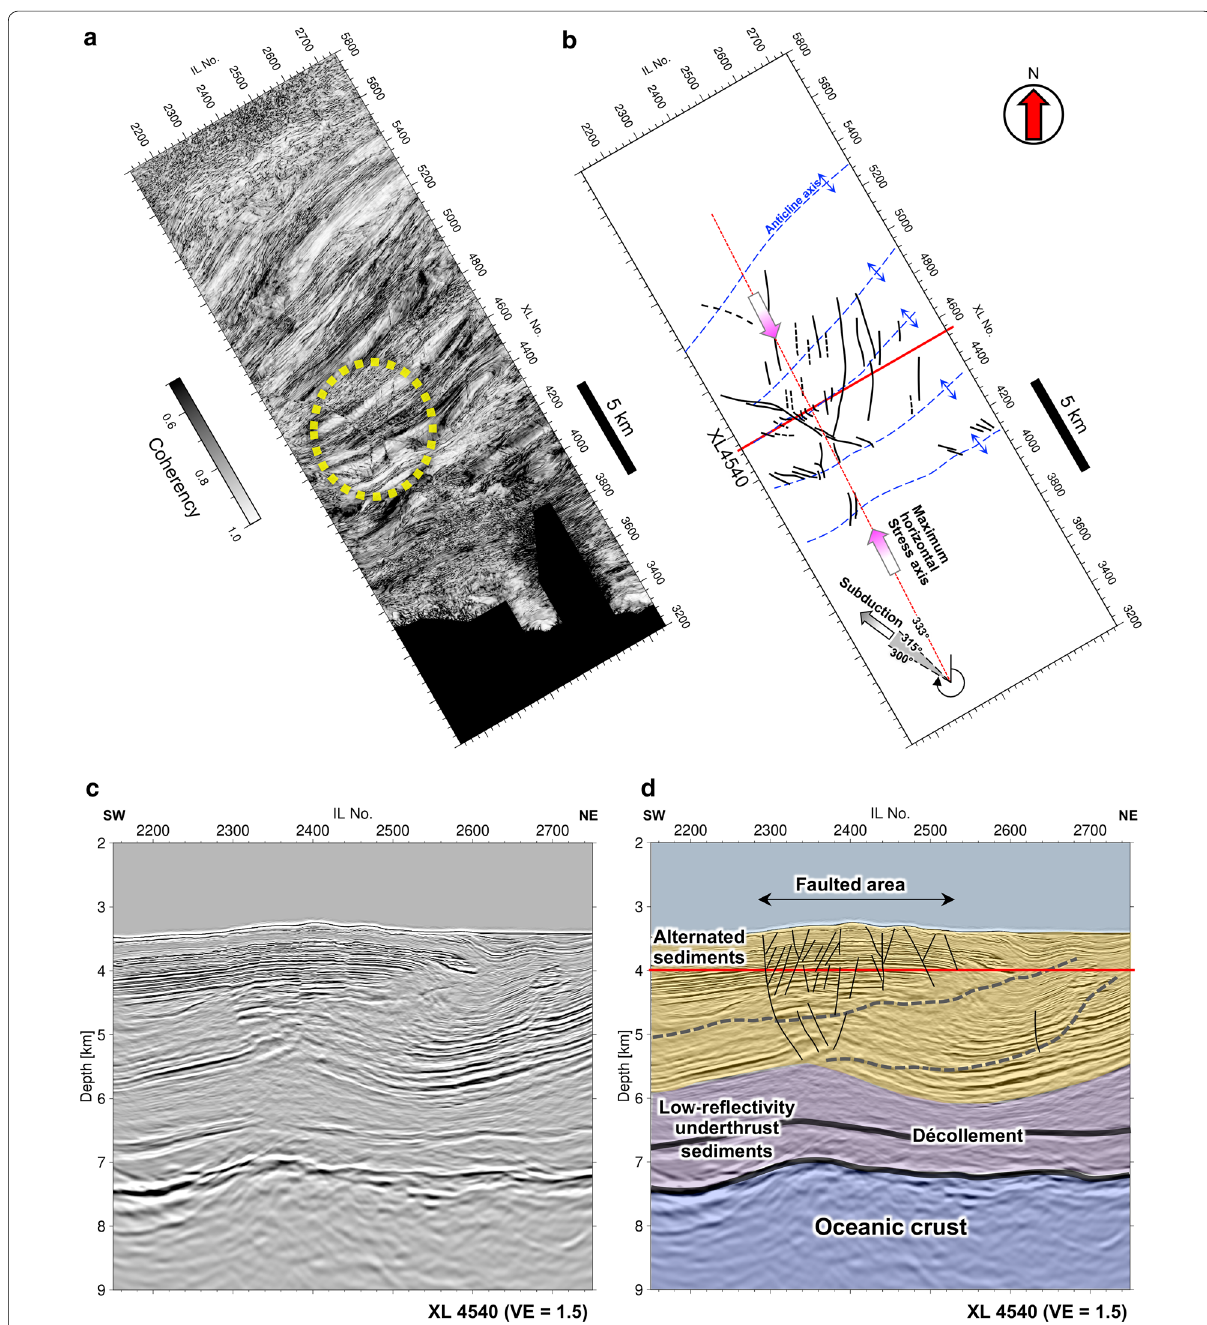
Fig. 5 Fault distribution in the shallow sediments. a A horizontal slice of the coherence cube at a depth of 4 km. Conjugate faults cutting the in-sequence thrusts are identified in the area with the yellow dashed circle. b The interpreted fault distributions identified on the horizontal slice are shown with black lines. The blue dashed lines indicate the anticlinal axes of folds in the imbricated thrust zone. The maximum horizontal axis inferred from the horizontal fault distribution is approximately 333° clockwise from the north, which is oblique to the subduction direction 300°–315°. c Vertical sections along the SW–NE direction (XL 4540) of the Kirchhoff PSDM image and d the same image as ( c ) with structural interpretation. The vertical displacements and topographic variations in the seafloor can be interpreted in the faulted area due to subsequent